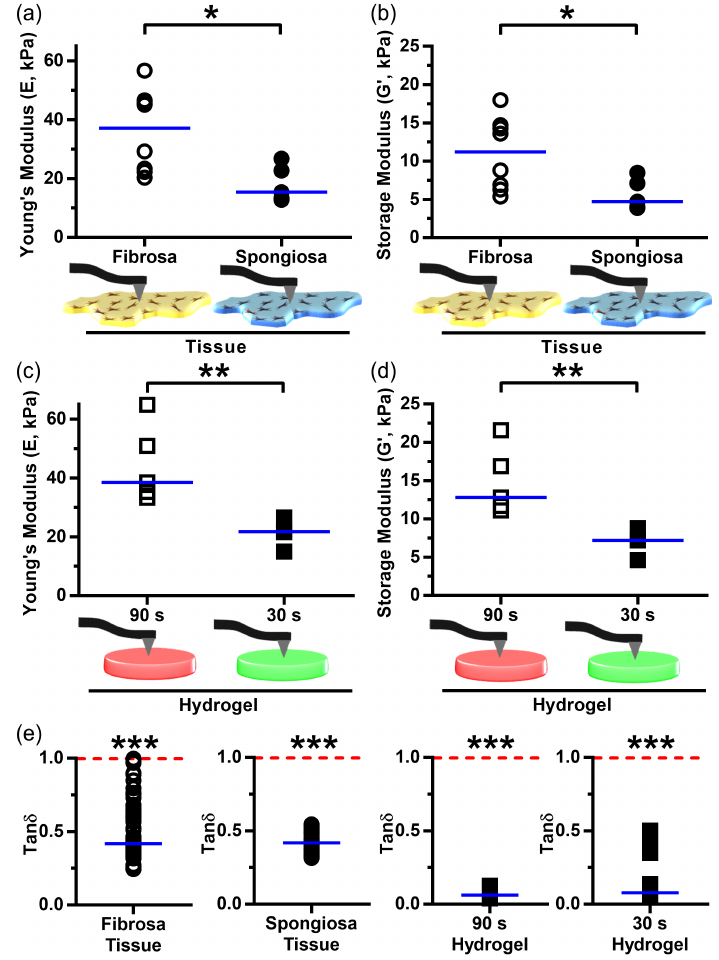
Figure 3. Measurement of layer-specific leaflet mechanical properties and matching of biomechanics with GelMA/HAMA hydrogels: ( a , b ) Nanoindentation of the CAVD leaflet layers determined that the median Young’s modulus of the fibrosa layer (37.1 kPa) was significantly higher than that of the spongiosa layer (15.4 kPa), and that the median storage modulus (G (cid:48) ) of the fibrosa layer (11.2 kPa) was significantly higher than that of the spongiosa layer (4.7 kPa); ( c , d ) Nanoindentation of hybrid hydrogels found that the median Young’s modulus of the 5% GelMA/1% HAMA hydrogel after UV crosslinking for 90 s (38.5 kPa) was significantly higher than that of the 5% GelMA/1% HAMA/30 s crosslinked hydrogel (21.7 kPa). GelMA/HAMA gels crosslinked for 90 s and 30 s recapitulated Young’s moduli of the fibrosa and spongiosa layers, respectively. G (cid:48) of the 90 s crosslinked hydrogel (12.8 kPa) was significantly higher than that of the 30 s crosslinked hydrogel (7.2 kPa). Hydrogel storage moduli again mimicked those properties of the native tissue; ( e ) The tan δ (G (cid:48)(cid:48) /G (cid:48) , loss tangent: viscous vs. elastic deformation) of individual samples within the fibrosa layer, spongiosa layer, 90 s hydrogel, and 30 s hydrogel were all significantly smaller than 1. In comparison to the leaflet layers, tan δ remained lower for both hydrogels. Median shown; * p < 0.05, ** p < 0.01, *** p < 0.001; n = 5–9 samples per condition (nine measurements per